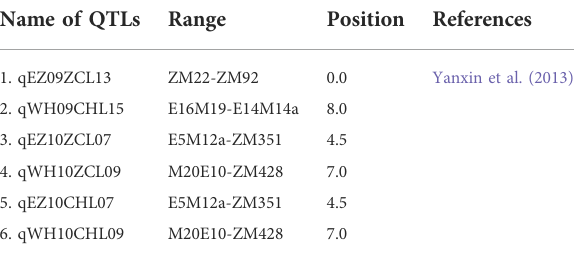
TABLE 10 QTLs associated with water logging tolerance in